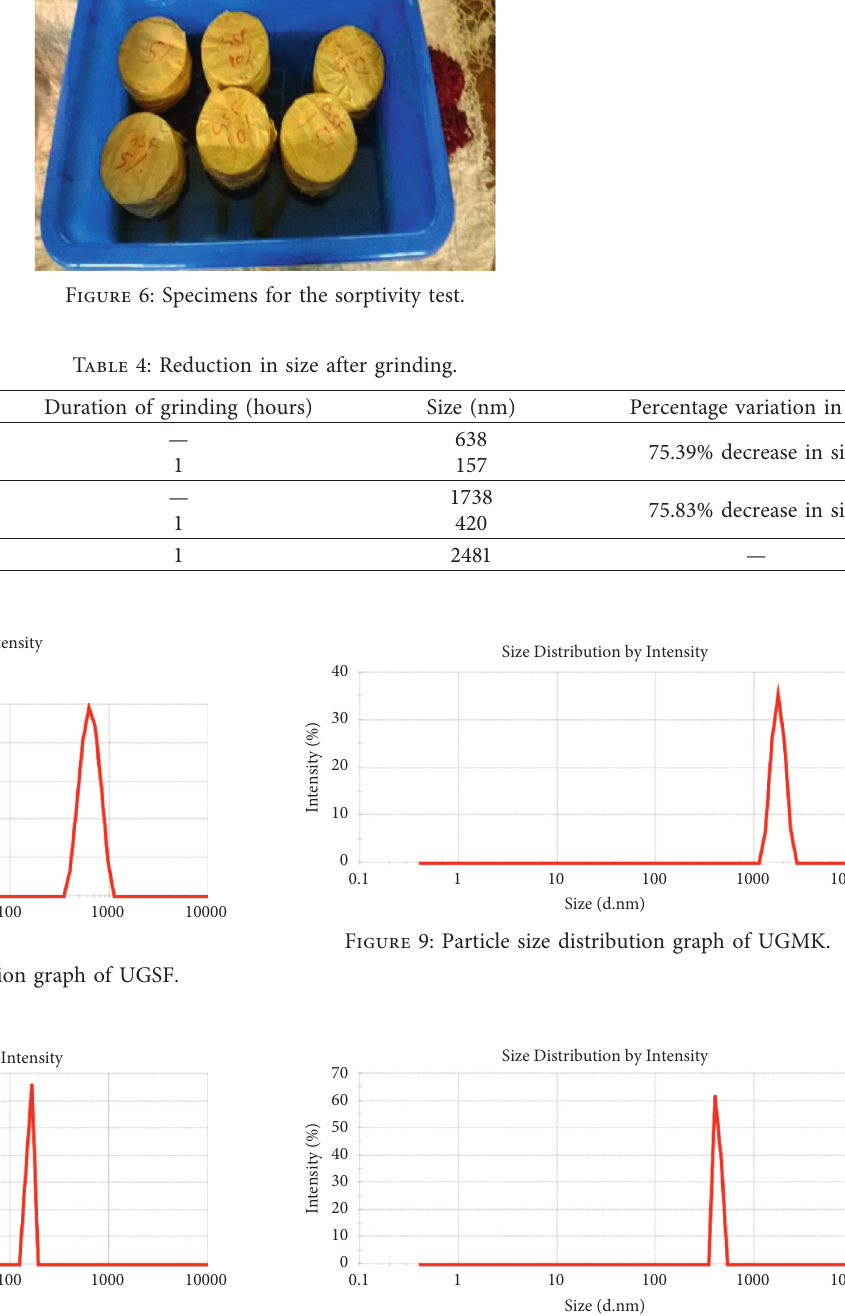
Figure 10: Particle size distribution graph of